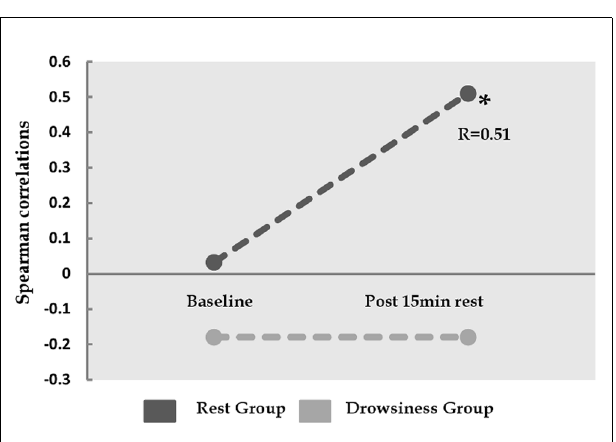
FIGURE 4 | Functional connectivity between dorsal and ventralACC. PanelA demonstrates the location of the dorsal and the ventral ACC ROIs analyzed in the current study. Panel B shows the change (mean and standard error) in correlation between these two ROIs from the baseline rest scan to